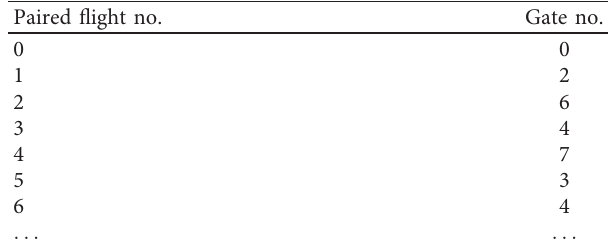
Table 3: An example of flight pair assignment. Paired flight no. Gate